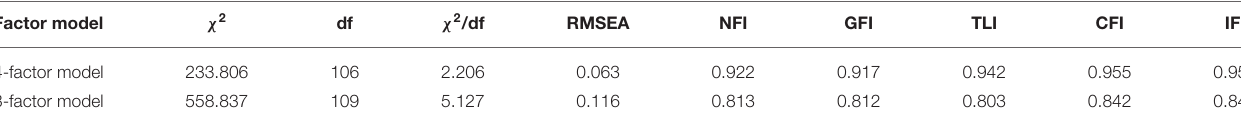
TABLE 4 | The model fit results of confirmatory factor analysis. Factor